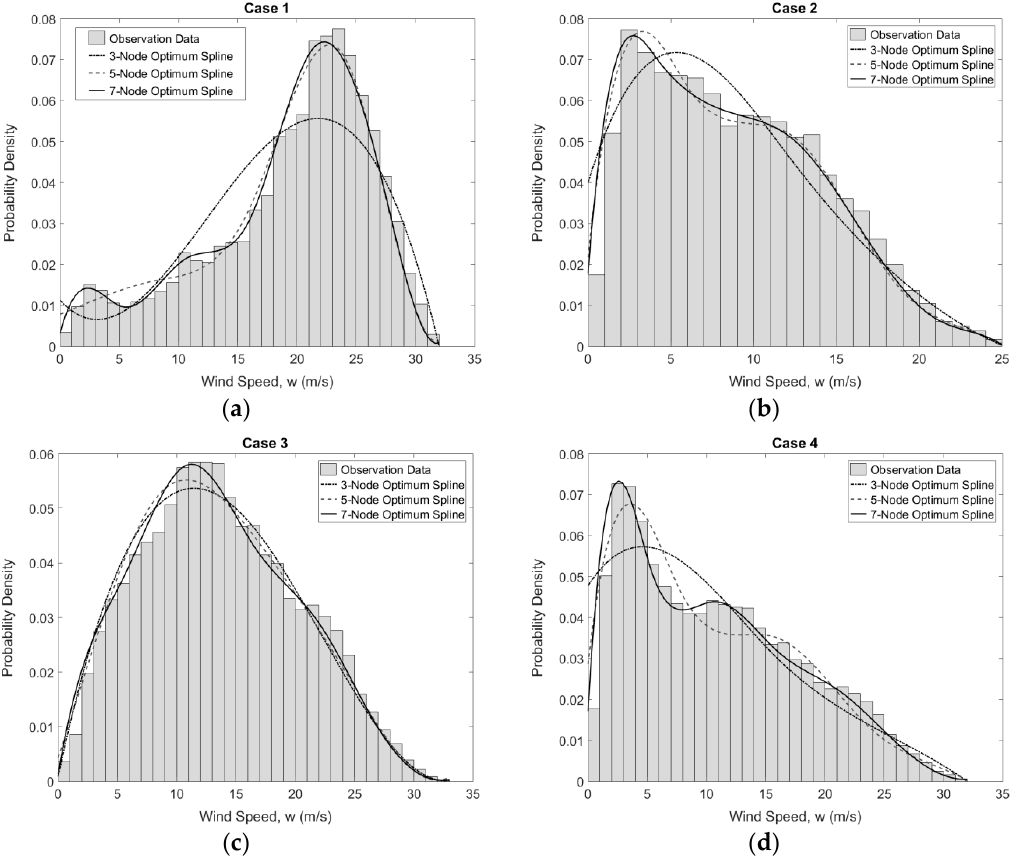
Figure 6. Comparison of the optimum splines based on different nodes. ( a ) Multimodal distribution 1; ( b ) Multimodal distribution 2; ( c ) Unimodal distribution; ( d ) Multimodal distribution 3.